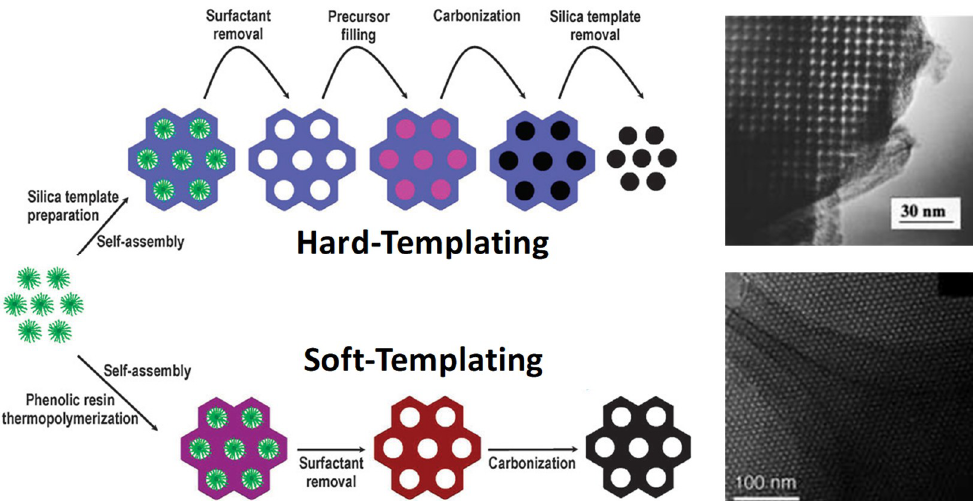
Figure 4. Schematics of hard- and soft-templating routes for the synthesis of ordered mesoporous carbon materials [82] and transmission electron microscopy images of hard-templated carbon (top) [83] and soft-templated carbon (bottom) [78]. Figures adapted/reproduced from [78], with permission from Wiley, 2005, [83], with permission from American Chemical Society, 1999, and [82], with permission from RSC Publishing, 2013.